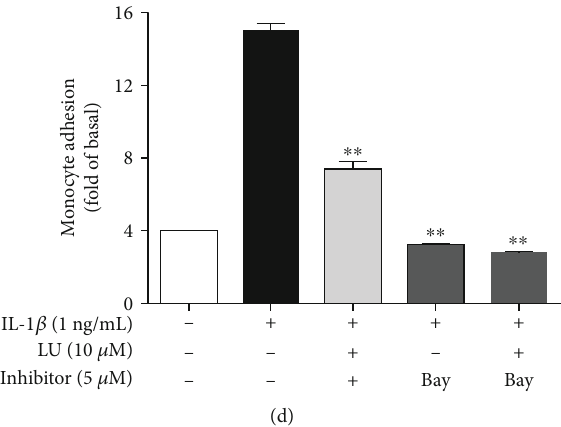
Figure 4: Luteolin inhibited NF- κ B activation and thereby suppressed THP-1 cell adherence to IL-1 β -stimulated ARPE-19 cells. Cells were pretreated with di ff erent doses of luteolin (LU) and then incubated with IL-1 β (1 ng/mL) for 15min. NF- κ B p65 translocation was evaluated by immuno fl uorescence staining. Green: location of the p65 subunit. Blue: DAPI for nuclear staining. (a) DAPI staining revealed that luteolin attenuated NF- κ B p65 translocation in IL-1 β -stimulated ARPE-19 cells. (b) Western blots show the levels of phosphorylated I κ B protein expression. (c) Luteolin suppressed THP-1 adhesion. ARPE-19 cells were pretreated with 10 μ M luteolin or 5 μ M Bay 117082 for 1h and then cocultured with labeled THP-1 cells. (d) Fluorescence intensity showed THP-1 cell adhesion to IL-1 β -stimulated ARPE-19 cells, which was used to quantify calcein-AM fl uorescence. Data represent the mean ± SD . ∗∗ p < 0 : 01 , compared to ARPE-19 cells stimulated with IL-1 β